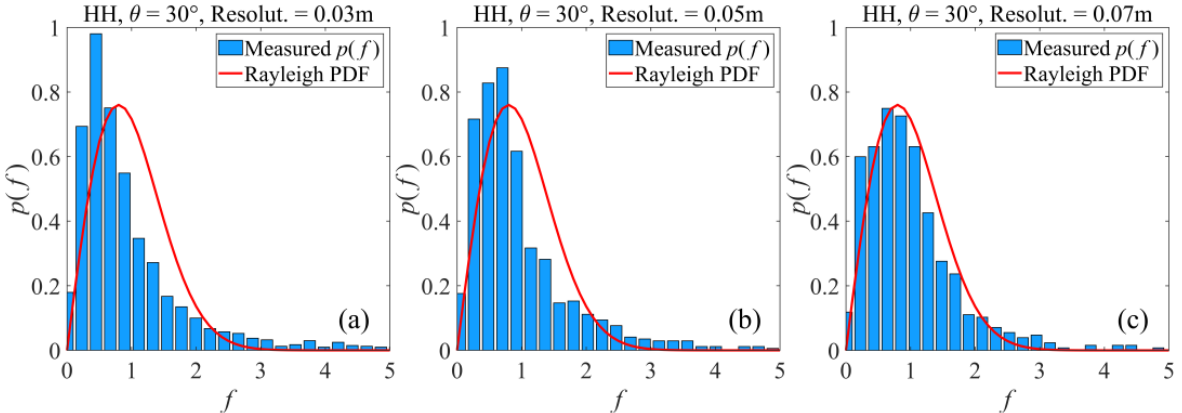
Figure 19. Measured and theoretical PDFs of the SAR images with different resolutions of Resolut. = ( a ) 0.03 m, ( b ) 0.05 m, and ( c ) 0.07 m at HH polarization and an incidence angle of 30°.